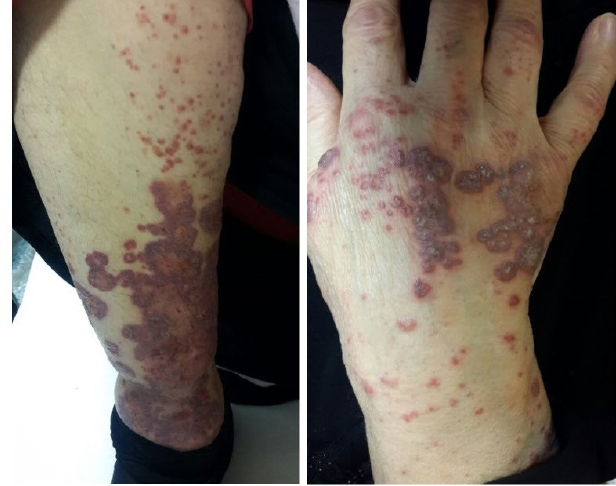
Figure 1. Palpable plaque in the erythematous and purpuric